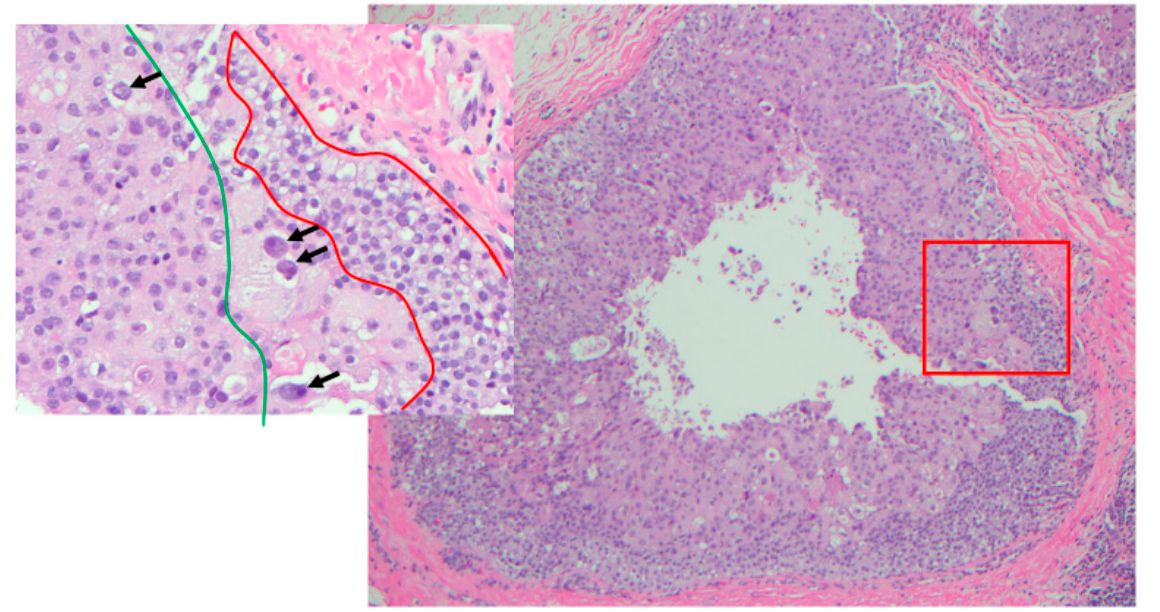
Figure 7. Heterogeneity of nuclear grade within the same duct (H&E 10×); in box LG (within red zone), IG (with green zone) and HG (arrows) (H&E